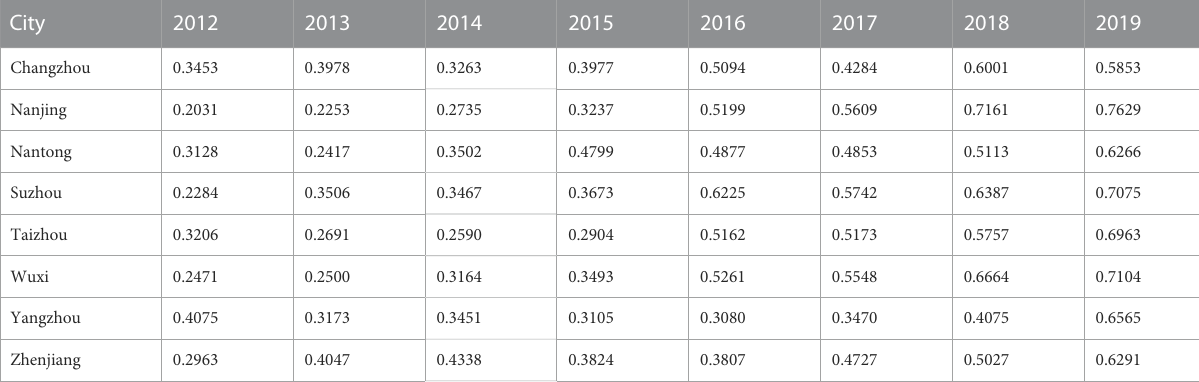
TABLE 4 Water environment carrying status index of eight cities along the Yangtze River in Jiangsu province from the city view by the EW method.